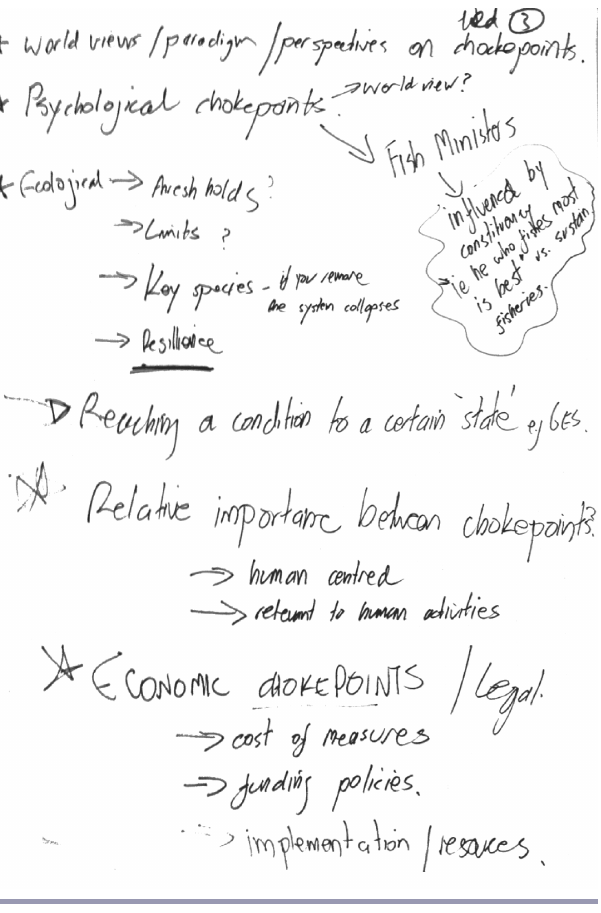
Fig. 2. Workshop example of working through definitions of the problem